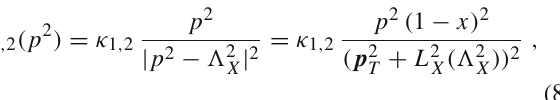
(cid:14) + 2 p 2 ( p 2 + x M 2 ) g 2 T T T X